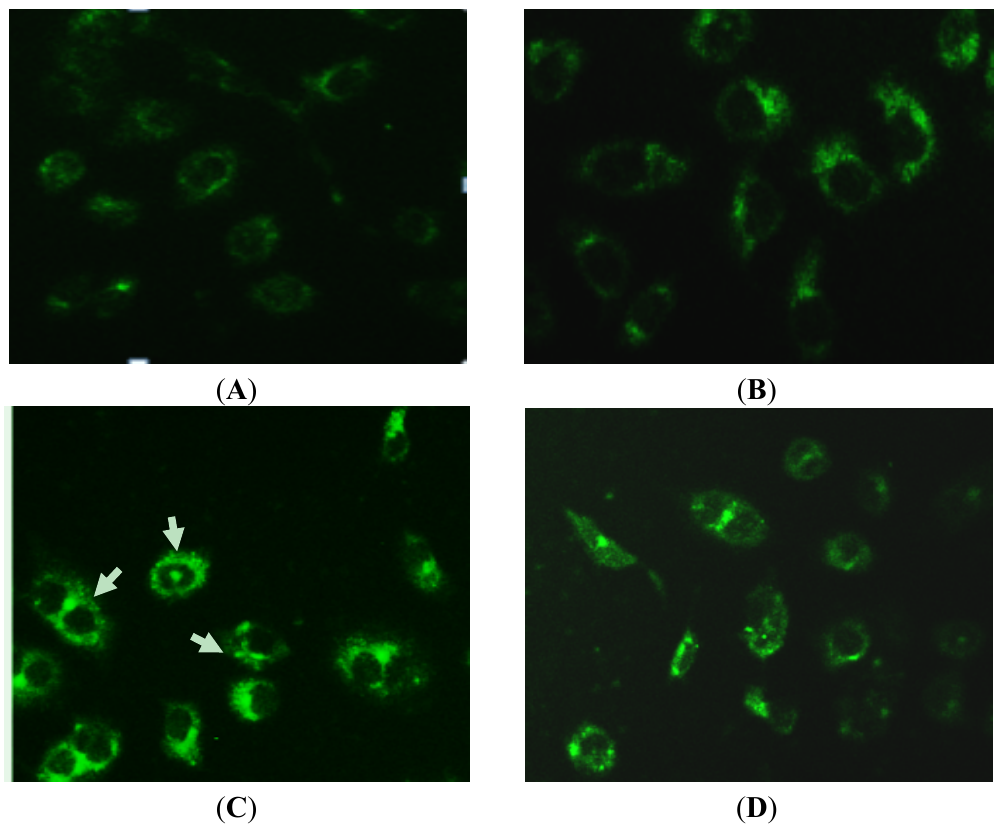
Figure 4. MDC-labeled autophagic vacuoles in PC-2 cells by fluorescence microscope after treatment with Rapa. Autophagic vacuoles were labeled with 0.05 mmol/L MDC in phosphatebuffered saline (PBS) at 37 °C for 10 min. ( A ) 0 nmol/L Rapa group; ( B ) 10 nmol/L Rapa group; ( C ) 50 nmol/L Rapa group; ( D ) 50 nmol/L Rapa + 3-MA group